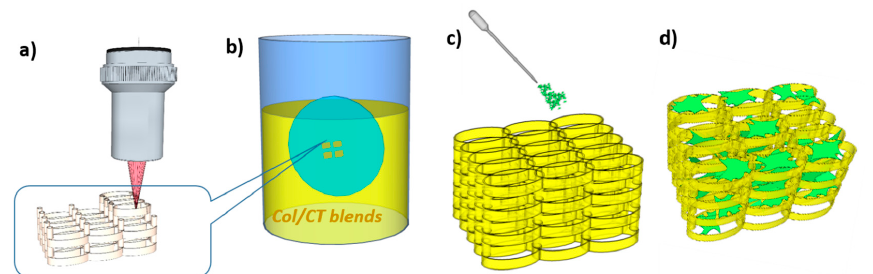
Figure5. ( a Figure 5. ( a ) Fabrication of complex 3D structures by laser direct writing via two-photons